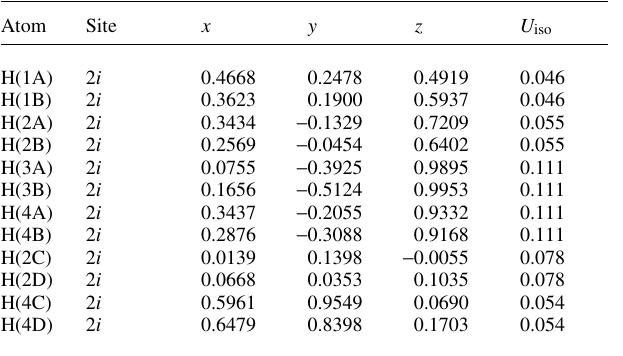
Table 2. Atomic coordinates and displacement parameters (in Å 2 )